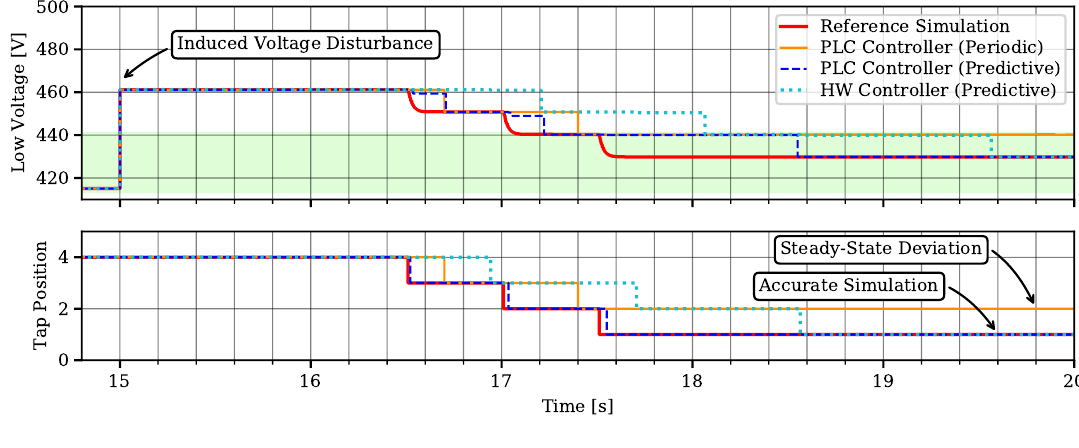
Figure 5. Exemplary switching